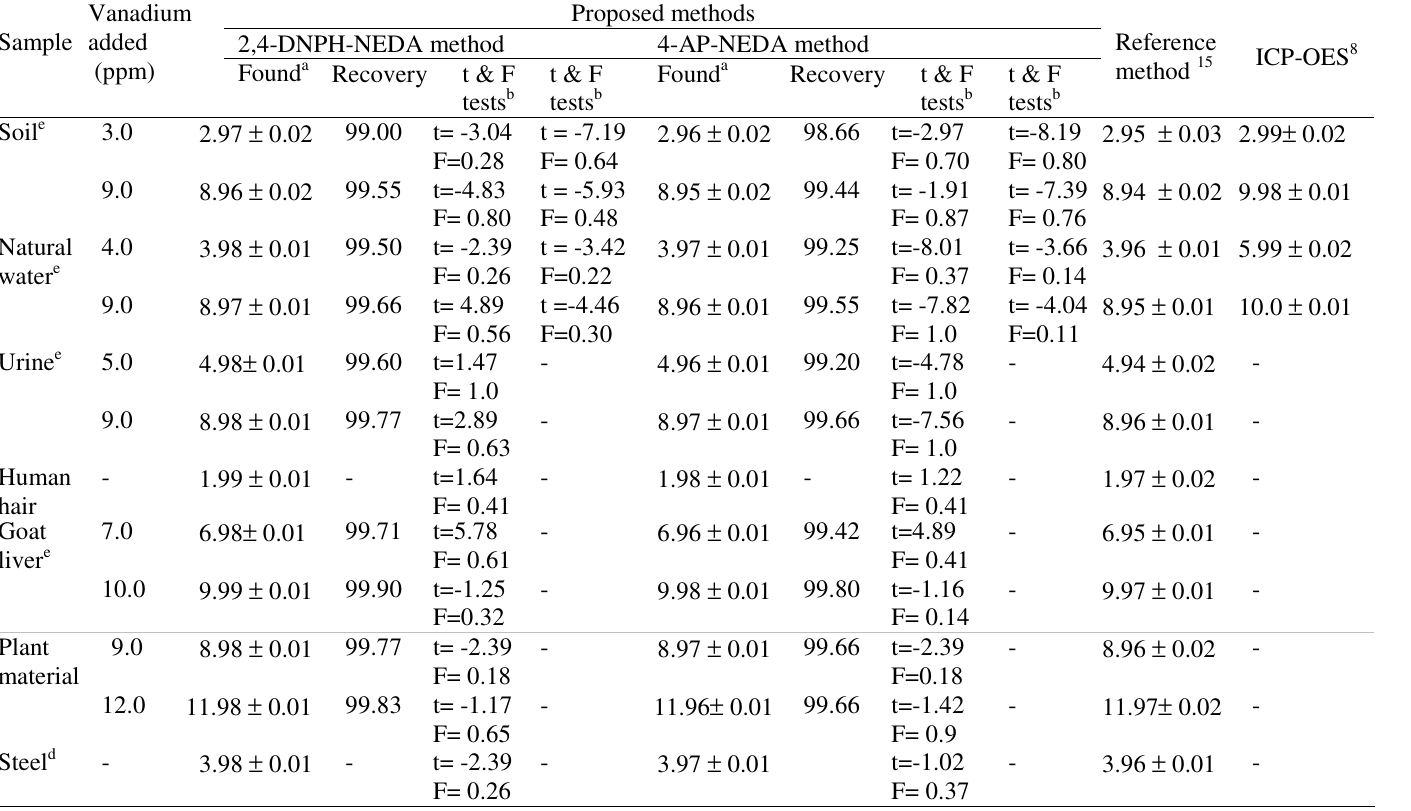
Table 3. Determination of Vanadium (V) in various